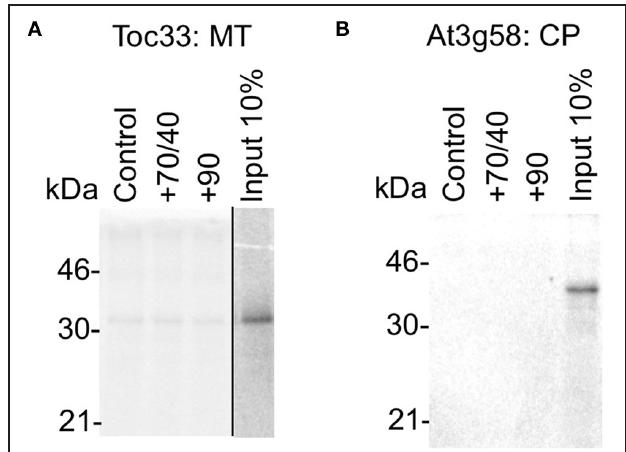
FIGURE 7 | Protein mistargeting to single organelles does not occur in the absence of cytosolic components. (A) Radio-labeled Toc33 protein derived from RNCs was incubated in a targeting assay with mitochondria (MT), with the addition of cytosolic components as indicated; control is buffer only, and chaperones (Hsp) are indicated by their numbers (70/40 or 90). Membranes were refractionated and washed with carbonate for analysis by SDS-PAGE. 10% of protein input is shown, and the protein molecular weight markers are indicated in kDa. (B) Radio-labeled At3g58 protein derived from RNCs was incubated in a targeting assay with chloroplasts (CP), and otherwise processed as described for part